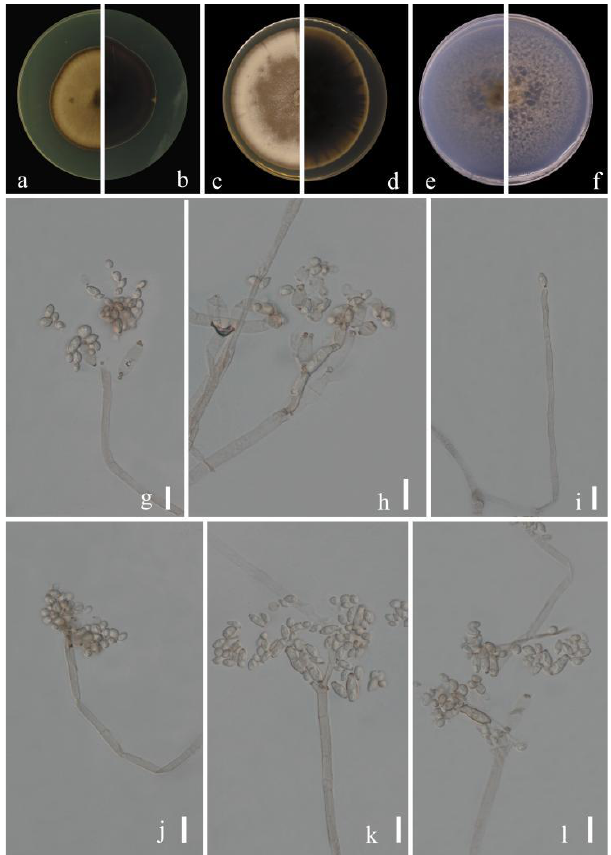
Figure 3. Cladosporium congjiangedsis (HGUP 21208, holotype). ( a , b ) Culture on PDA from above and reverse. ( c , d ) Culture on MEA from above and reverse. ( e , f ) Culture on SNA from above and reverse. ( g – l ) Conidiophores, secondary ramoconidia and conidia on SNA. Scale bars = 10 µm.